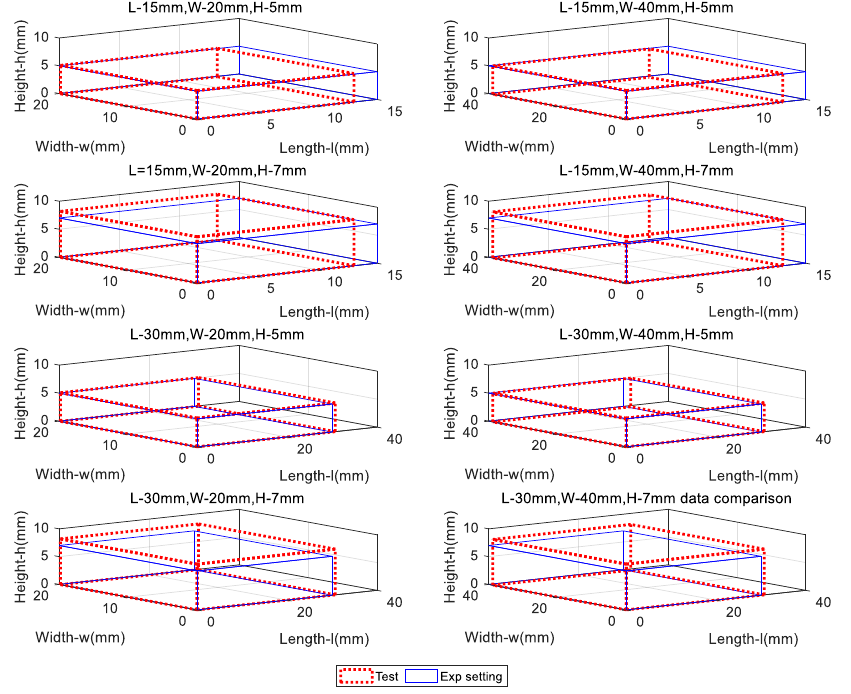
Figure 14. Comparison of visualized mock debris block shapes between the test groups and experimental settings.